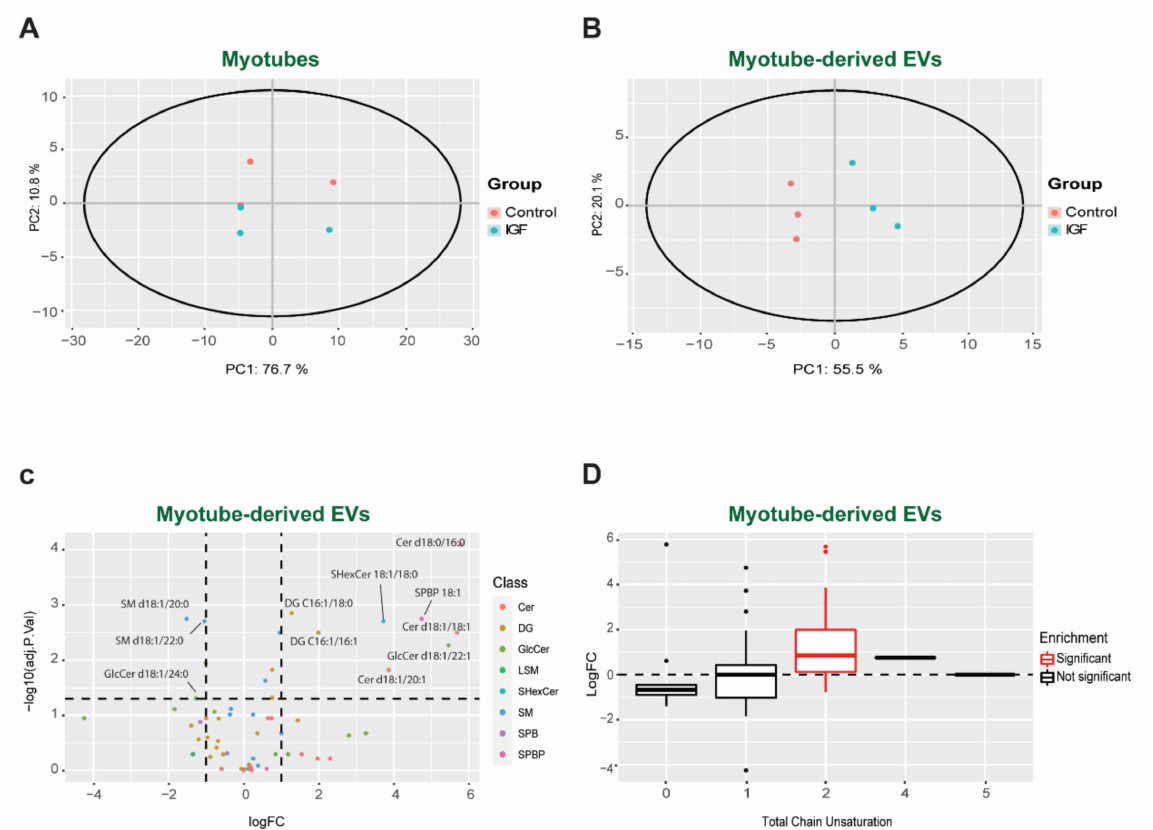
Figure 3. EV lipid profile characterization. Principal component analysis (PCA) plot between the control and IGF in myotubes ( A ) and myotube-derived EVs ( B ); ( C )—volcano plot highlighting the significant lipid differences between the control and IGF EV; ( D )—lipid chain plot revealing an increase in the degree of carbon chain saturation between the control and IGF EVs. ( C , D ) Data are represented as fold change in the IGF-treated myotube-derived EVs compared to the control. Significance is denoted (red) with an adjusted p -value < 0.05 ( n =